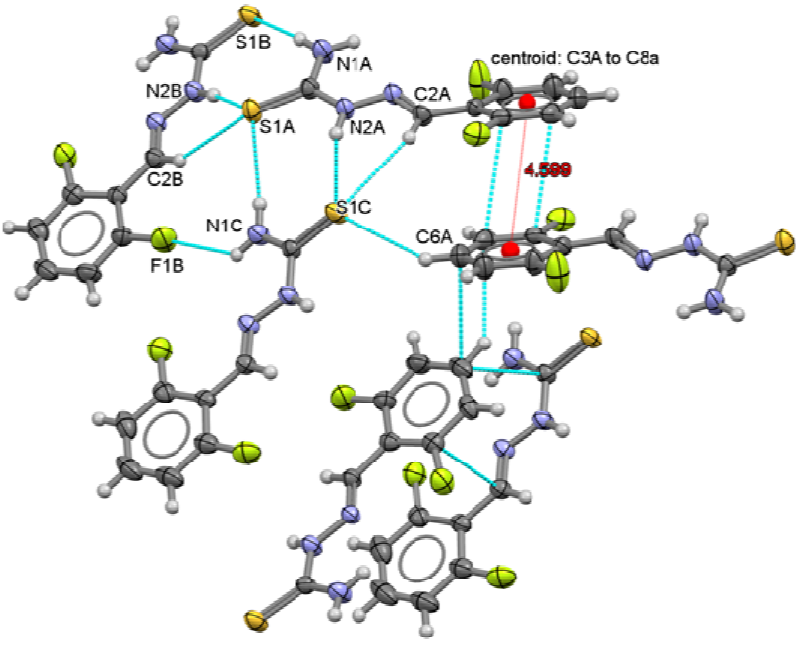
Figure 9. Packing arrangement of 2,6-C interactions between thiophenolate rings.